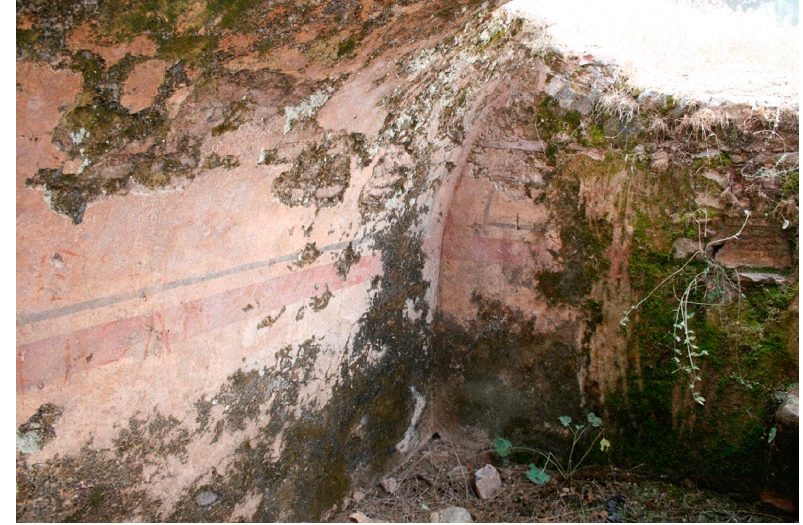
Figure 26. Sardis, Artemis precinct tomb (Tomb AT 2, Appendix A.10), northeast corner. © Archaeological Exploration of Sardis/President and fellows of Harvard College.